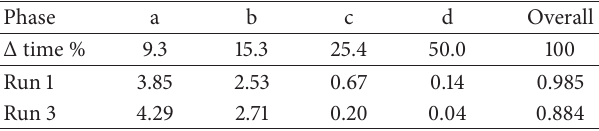
Table 6: Average dimensionless torques related to the oil-gear interaction phases during the second impact: runs 1 and